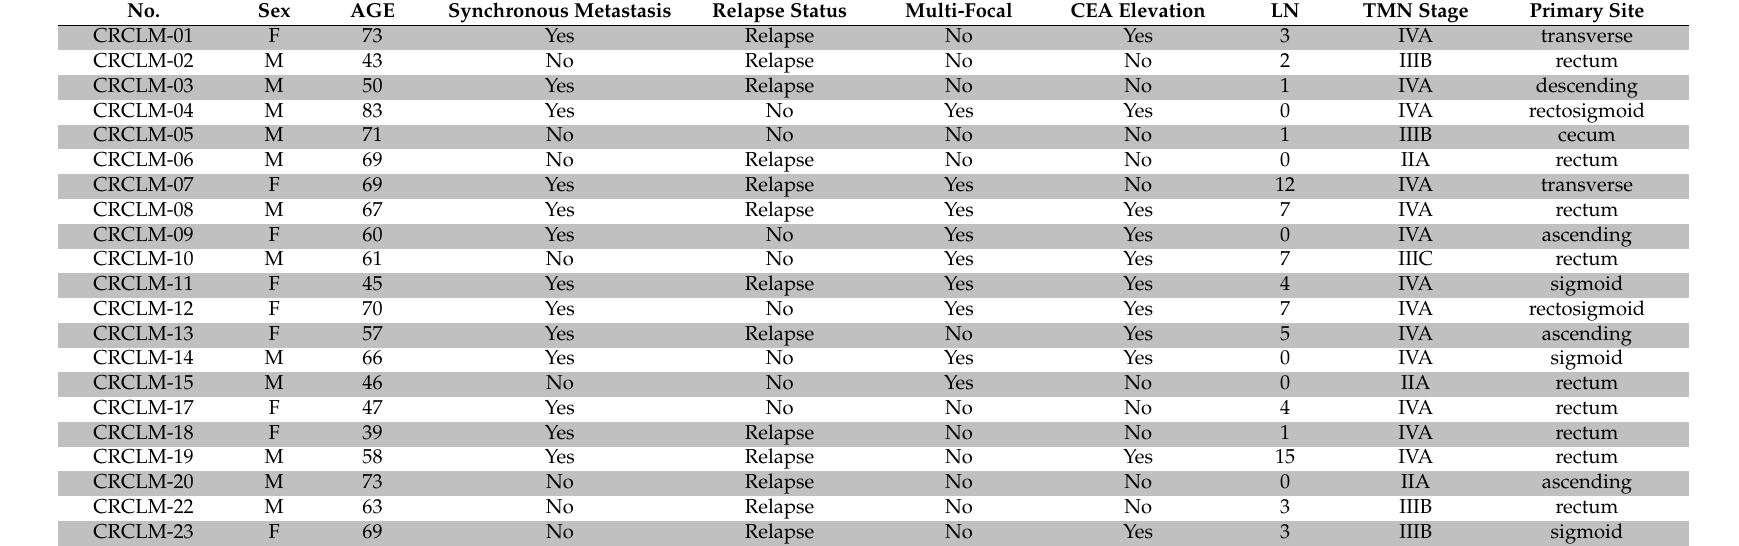
Table 1. Clinical characteristics of the colorectal liver metastases (CRCLM)